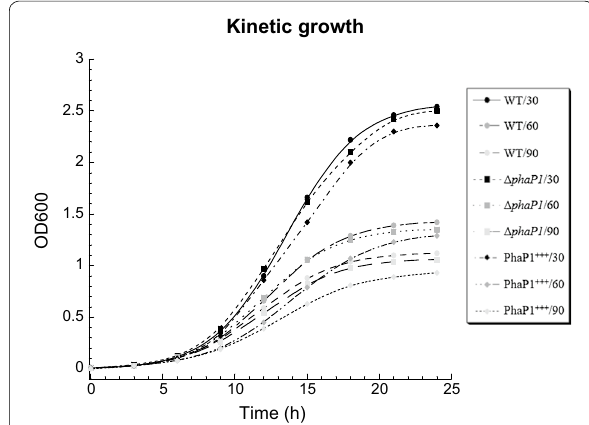
Fig. 3 Growth kinetic behavior of A. brasilense strains. A. brasilense strains were inoculated in flasks containing minimal medium supplemented with malic acid and ammonium chloride, at C:N ratios of 30:1, 60:1 and 90:1, to an OD600 of 0.01. Samples were taken every 3 h for 24 h and measured spectrophotometrically at an OD600. Growth of A. brasilense Sp7 (WT) (circles), A. brasilense Δ phaP1 (Δ phaP1 ) (squares) and A. brasilense PhaP1 +++ (PhaP1 +++ ) (diamonds). Dark spots indicate a C:N ratio of 30:1, gray spots for a C:N ratio of 60:1 and light gray spots denotes a C:N ratio of